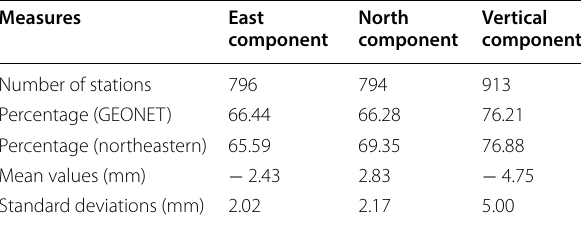
The first row lists the numbers of stations to move westward, northward and downward, respectively. The next two rows list the percentages of displacements from the whole GEONET network and the northeastern Japan, respectively. The percentages in the vertical component are referred to downward movement. The fourth row lists the mean values of displacements in the east, north and vertical directions. The last row gives the robust adaptive mean values of standard deviations of displacements between two consecutive epochs, as computed from the 30 min of GEONET GPS data before the